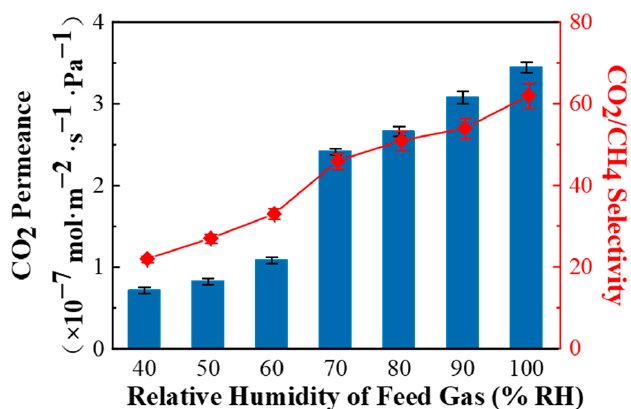
Figure 7. Effect of relative humidity of feed gas on the CO 2 /CH 4 (45/55 vol%) mixed gas separation performance of PPPS/PDMS/PSf composite membrane. Test conditions: 298 K and 0.15 MPa.